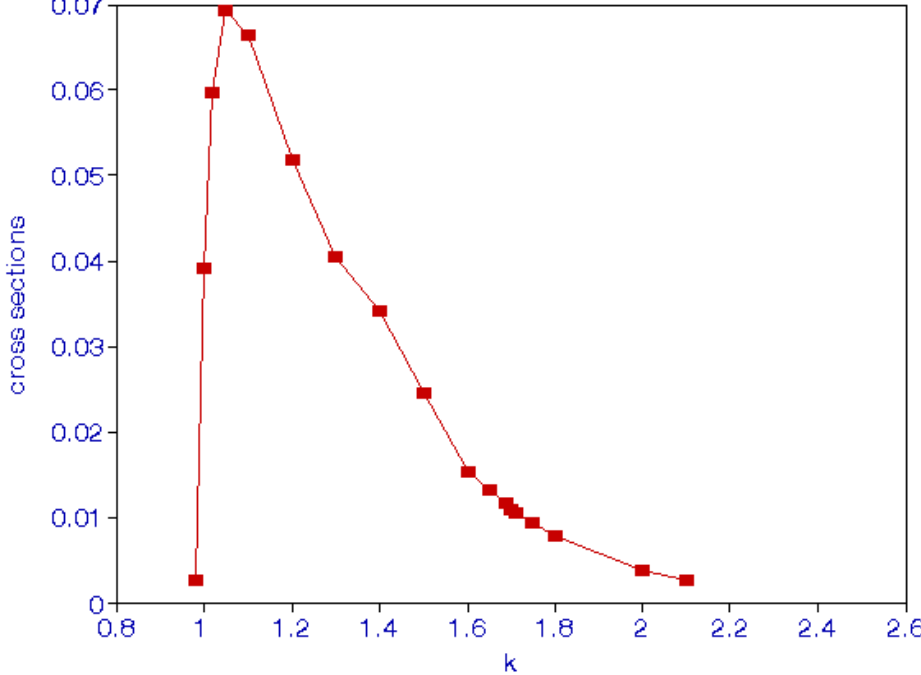
) vs. the incident momentum 0 2 a π